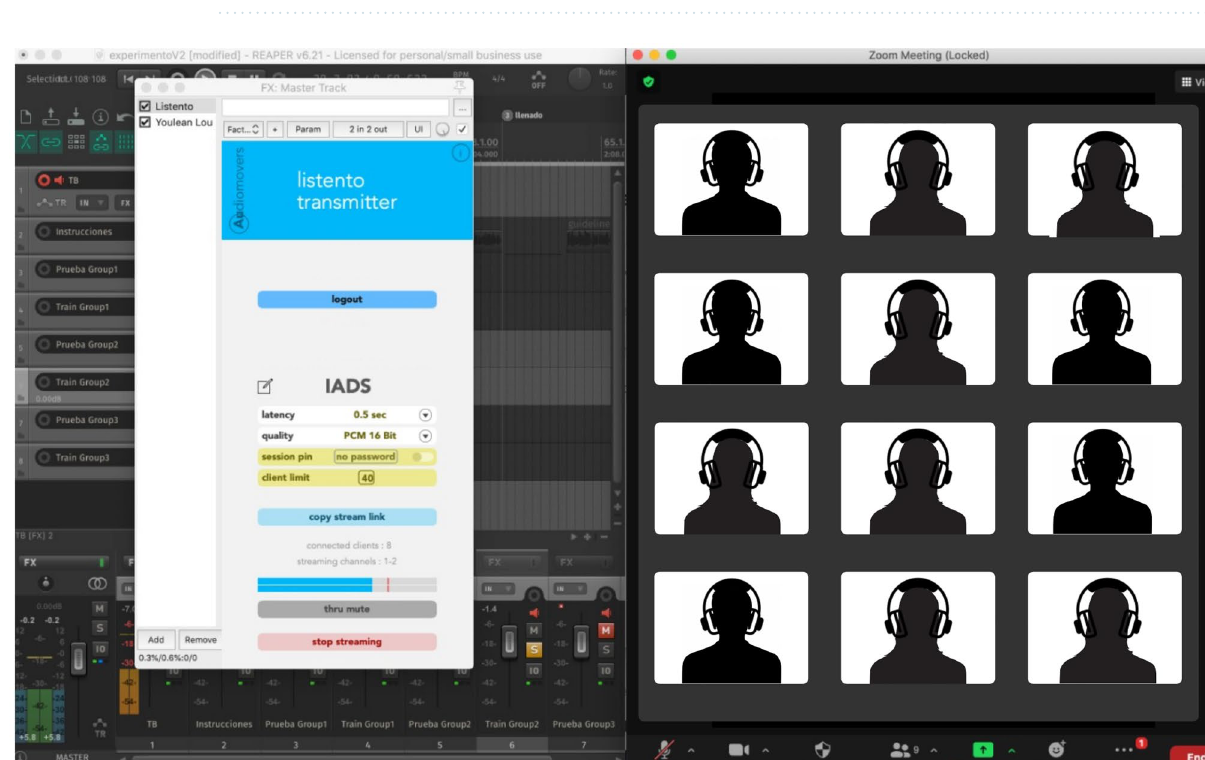
Figure 2. Virtual meeting. High-quality audio was transmitted in real time over the internet. Participants wore headphones during the